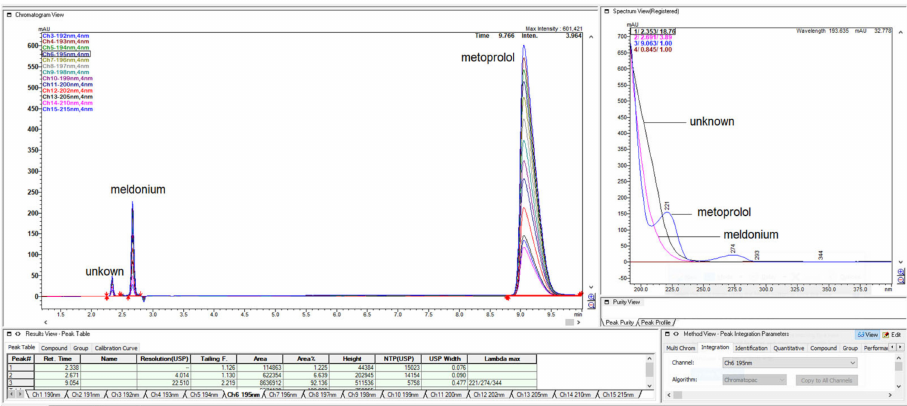
Figure 26. Chromatograms testing of column Zorbax CN-SB-250 × 4.6 mm with 20% ACN and 80% 13 mM (0.15% w / v ) NH 4 H 2 PO 4 and overlaid 15-channels of different UV-absorbing wavelengths on the left, extracted spectrum on